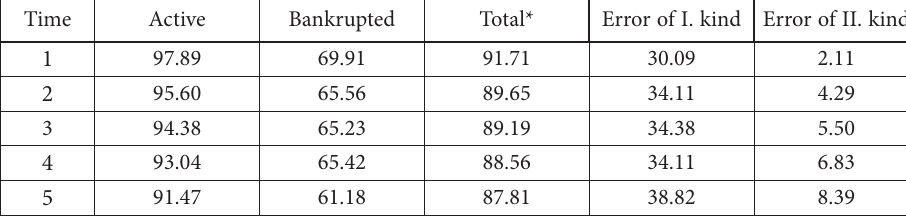
Table 2. Results of tested model I KR